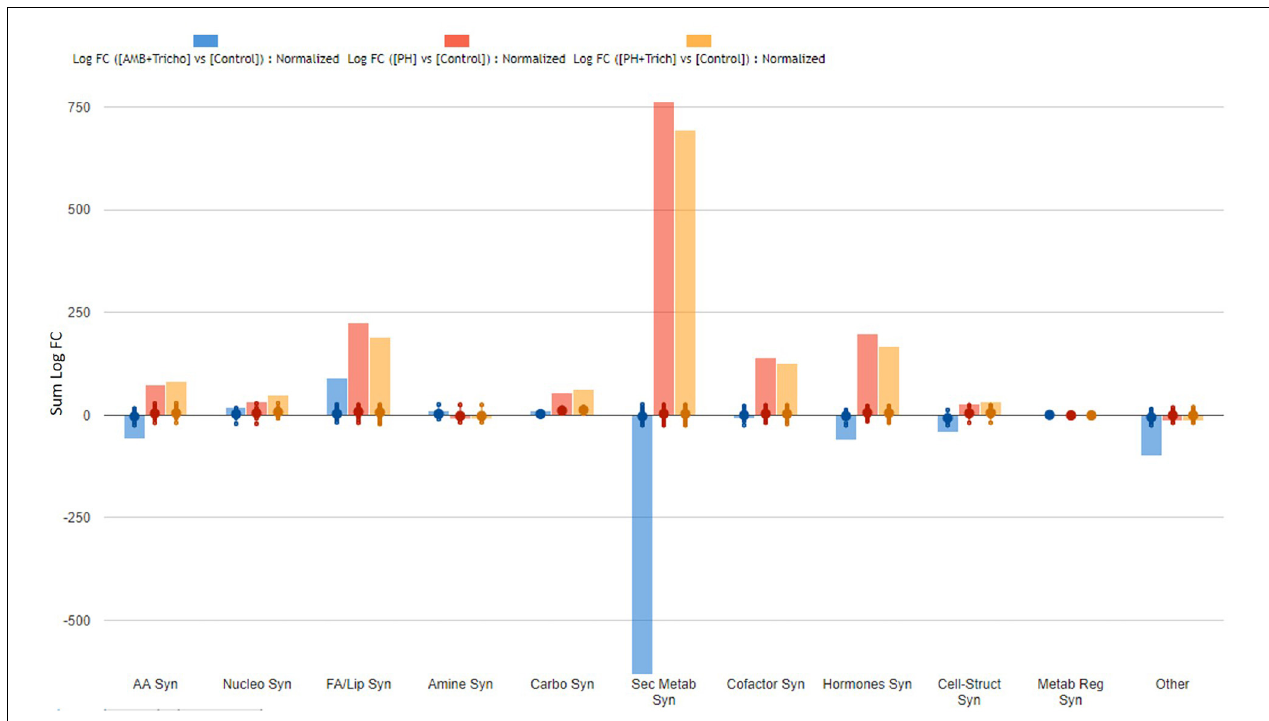
FIGURE 4 | Biosynthesis processes which take place in roots of maize plants treated with a consortium of arbuscular mycorrhizal fungi (AMF), Trichoderma koningii TK7, and rhizosphere bacteria or with a consortium of Trichoderma koningii TK7 and rhizosphere bacteria (Tricho) plus a protein hydrolyzate-based biostimulant (PH), or with a protein hydrolyzate-based biostimulant (PH). The metabolomic dataset produced through UHPLC-ESI/QTOF-MS was subjected to a Volcano Plot analysis ( P < 0.01, fold-change > 1.2) and differential metabolites were loaded into PlantCyc Pathway Tool (https://www.plantcyc.org/). The x-axis represents each set of subcategories while the y-axis corresponds to the cumulative